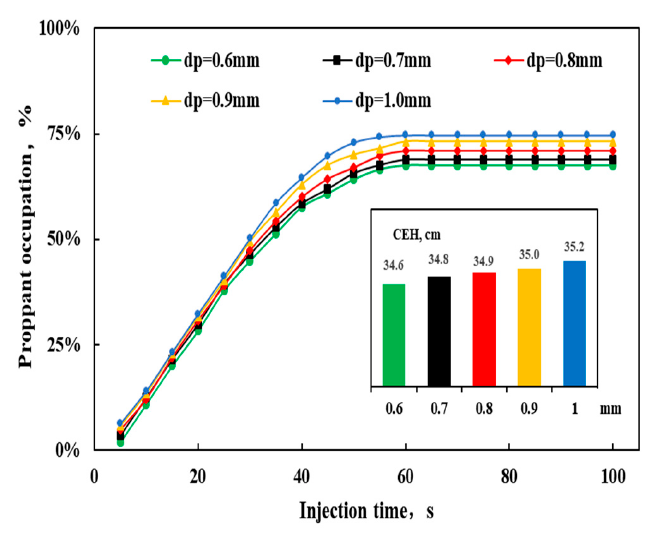
Figure 13. The curve for proppant occupation percentage in fracture change with time and comprehensive equilibrium H = height (CEH) for different particle diameter cases.